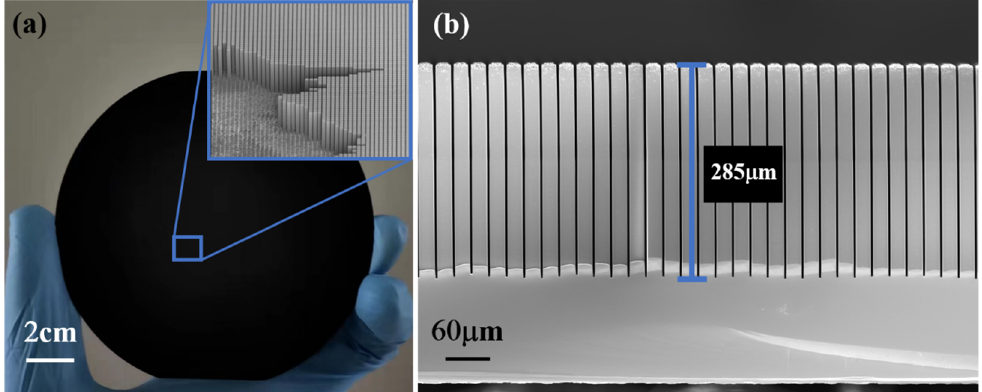
Figure 8. ( a ) An optical image of the fabricated high aspect ratio micropillar arrays on a 4-inch Si wafer, ( b ) The enlarged cross-sectional SEM images of ultra-high aspect ratio (>140:1) micropillars with smooth